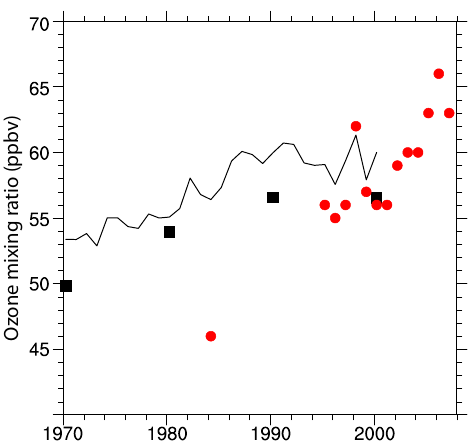
Fig. 11. Comparison between observed and modeled (present-day) annually aerosol optical depth at 500nm. The observed values are based on annually averaged AERONET optical depths (Holben et al.,